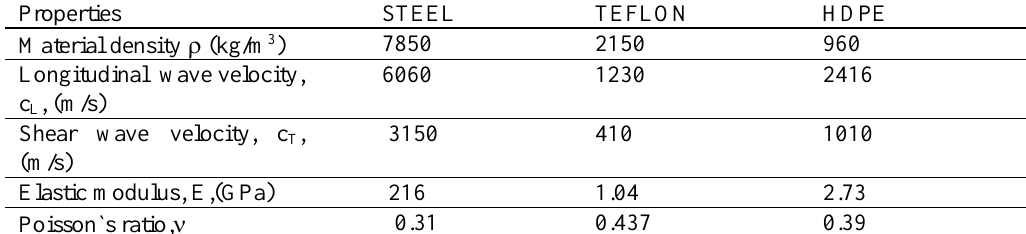
Table 2. Main properties of the striker’s